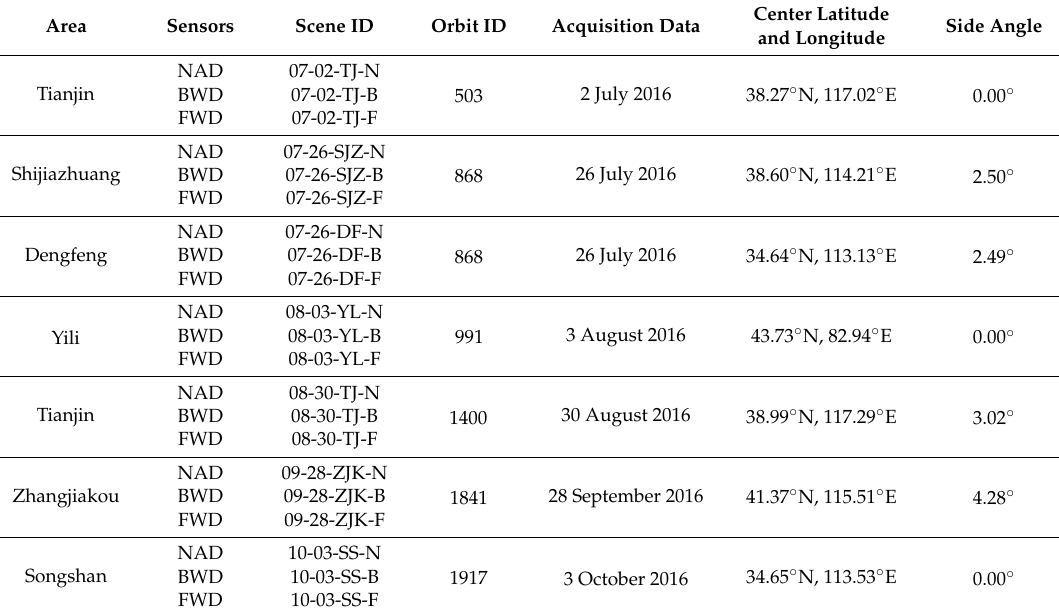
Table 2. Detailed information for experimental images in representative